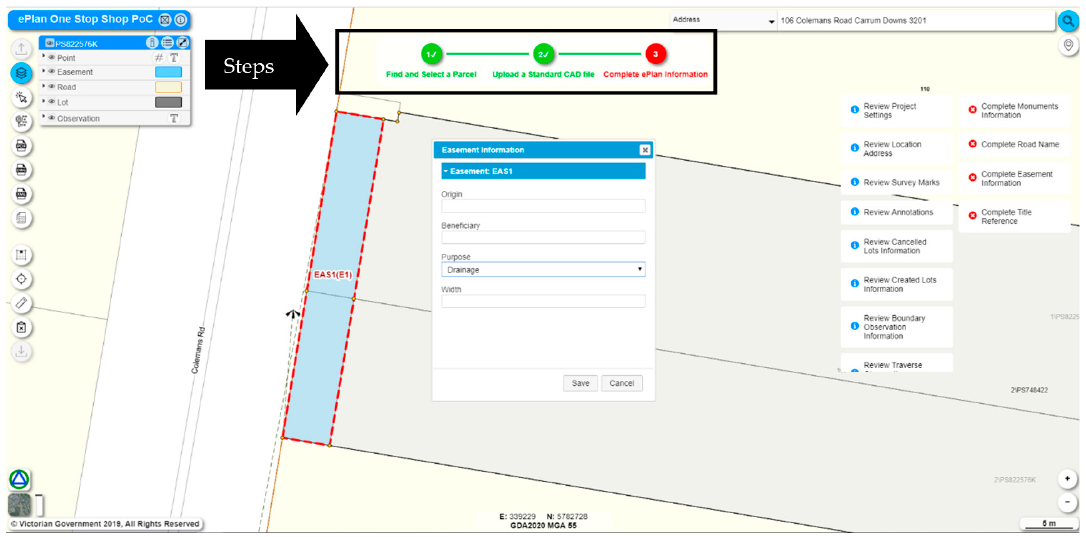
Figure 5. The steps of converting a standard CAD file to an ePlan LandXML file developed in